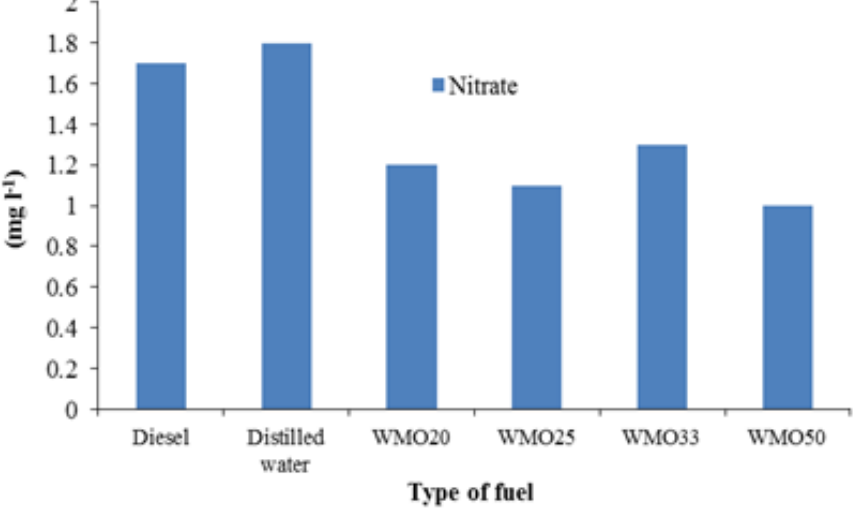
Figure 10. Proportion of nitrate in the solution during washing of the flue gas to different types of fuel.